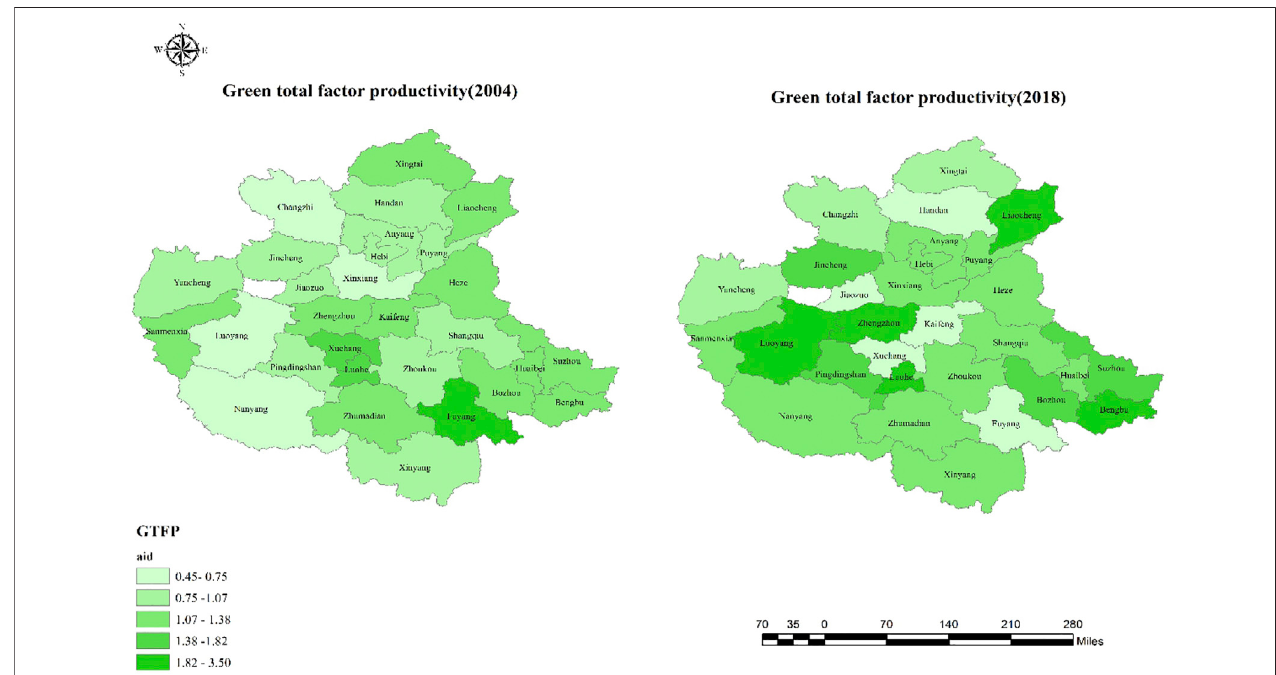
FIGURE 4 | Green total factor productivity of the CPUA in 2004 and 2018.